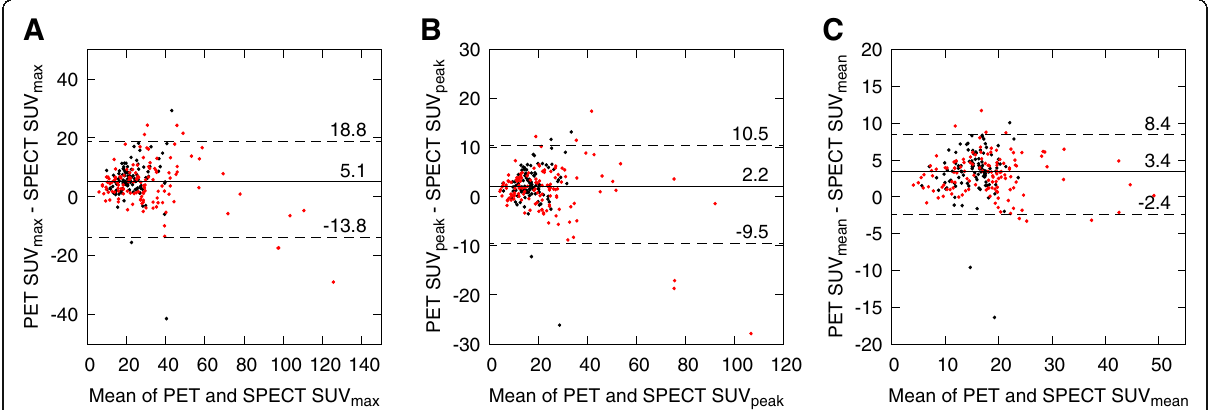
Fig. 3 Bland-Altman plots of a SUV max , b SUV peak , and c SUV mean from SPECT and PET data for all lesions. The x -axis represents the mean of SPECT and PET SUVs and the y -axis the difference between SPECT and PET SUVs. Metastatic lesions are marked in red and benign in black. Solid lines with numerical values denote median differences and dotted lines with values denote 95%